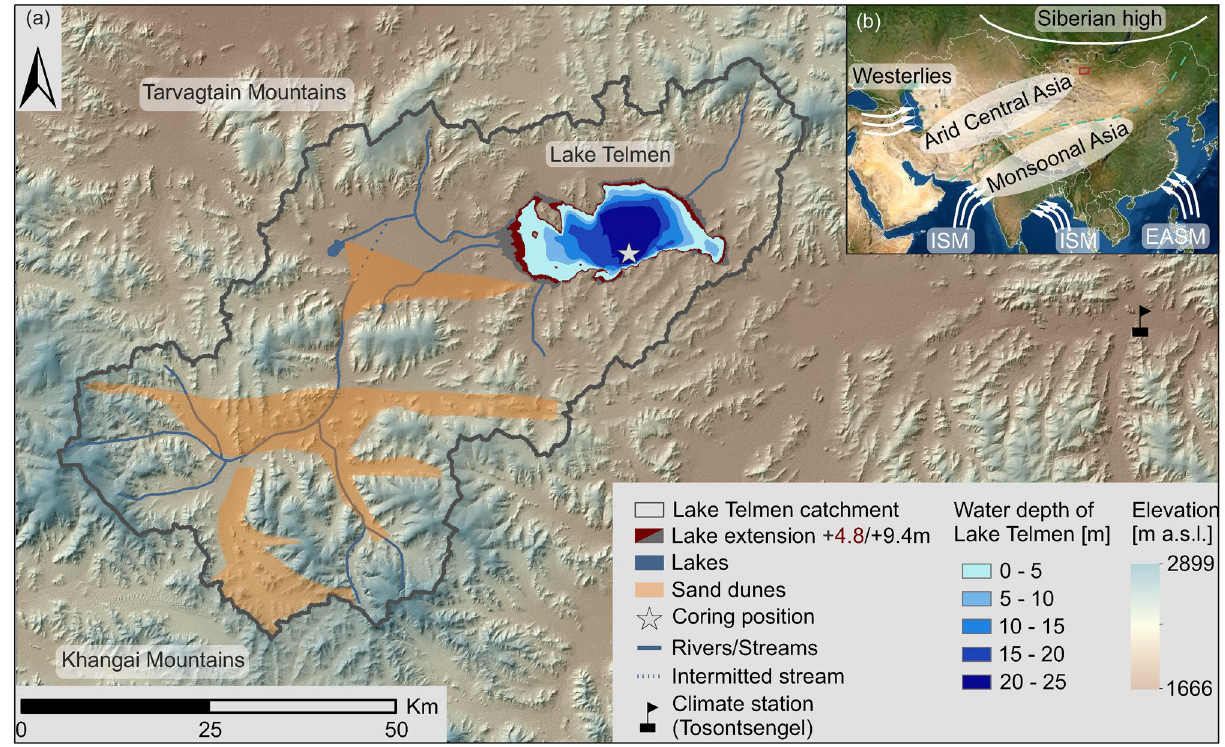
Figure 1. Regional setting of Lake Telmen. ( a ) Digital elevation (SRTM, 1 arc second; 30 m × 30 m) and bathymetric data show the catchment’s topography and the hydrography of Lake Telmen. The red/grey-shaded area around Lake Telmen indicates the former lake extent during the + 4.8 m/+ 9.4 m lake level high-stands (Peck et al. 22 ), the yellow-shaded areas indicate the extent of sand dunes. The coring position is marked by a grey star, and the climate station Tosontsengel by a black flag. ( b ) Inset map of Asia shows the extent of “Arid Central Asia” and “Monsoonal Asia”, the northern Monsoon boundary is illustrated by a green dashed line. The Mongolian study site is marked by a red box. The direction of major atmospheric circulation systems is illustrated by white arrows: The Westerlies, the East Asian summer monsoon (EASM), the Indian summer monsoon (ISM) and the Siberian high. The maps were created using ArcMap 10.6.1 (www. esri. com; ( a )) and SimpleMappr (www. simpl emappr. net; ( b )). In-map labels (mountains, atmospheric circulation systems) were added in CorelDraw 2019 (www. corel draw.